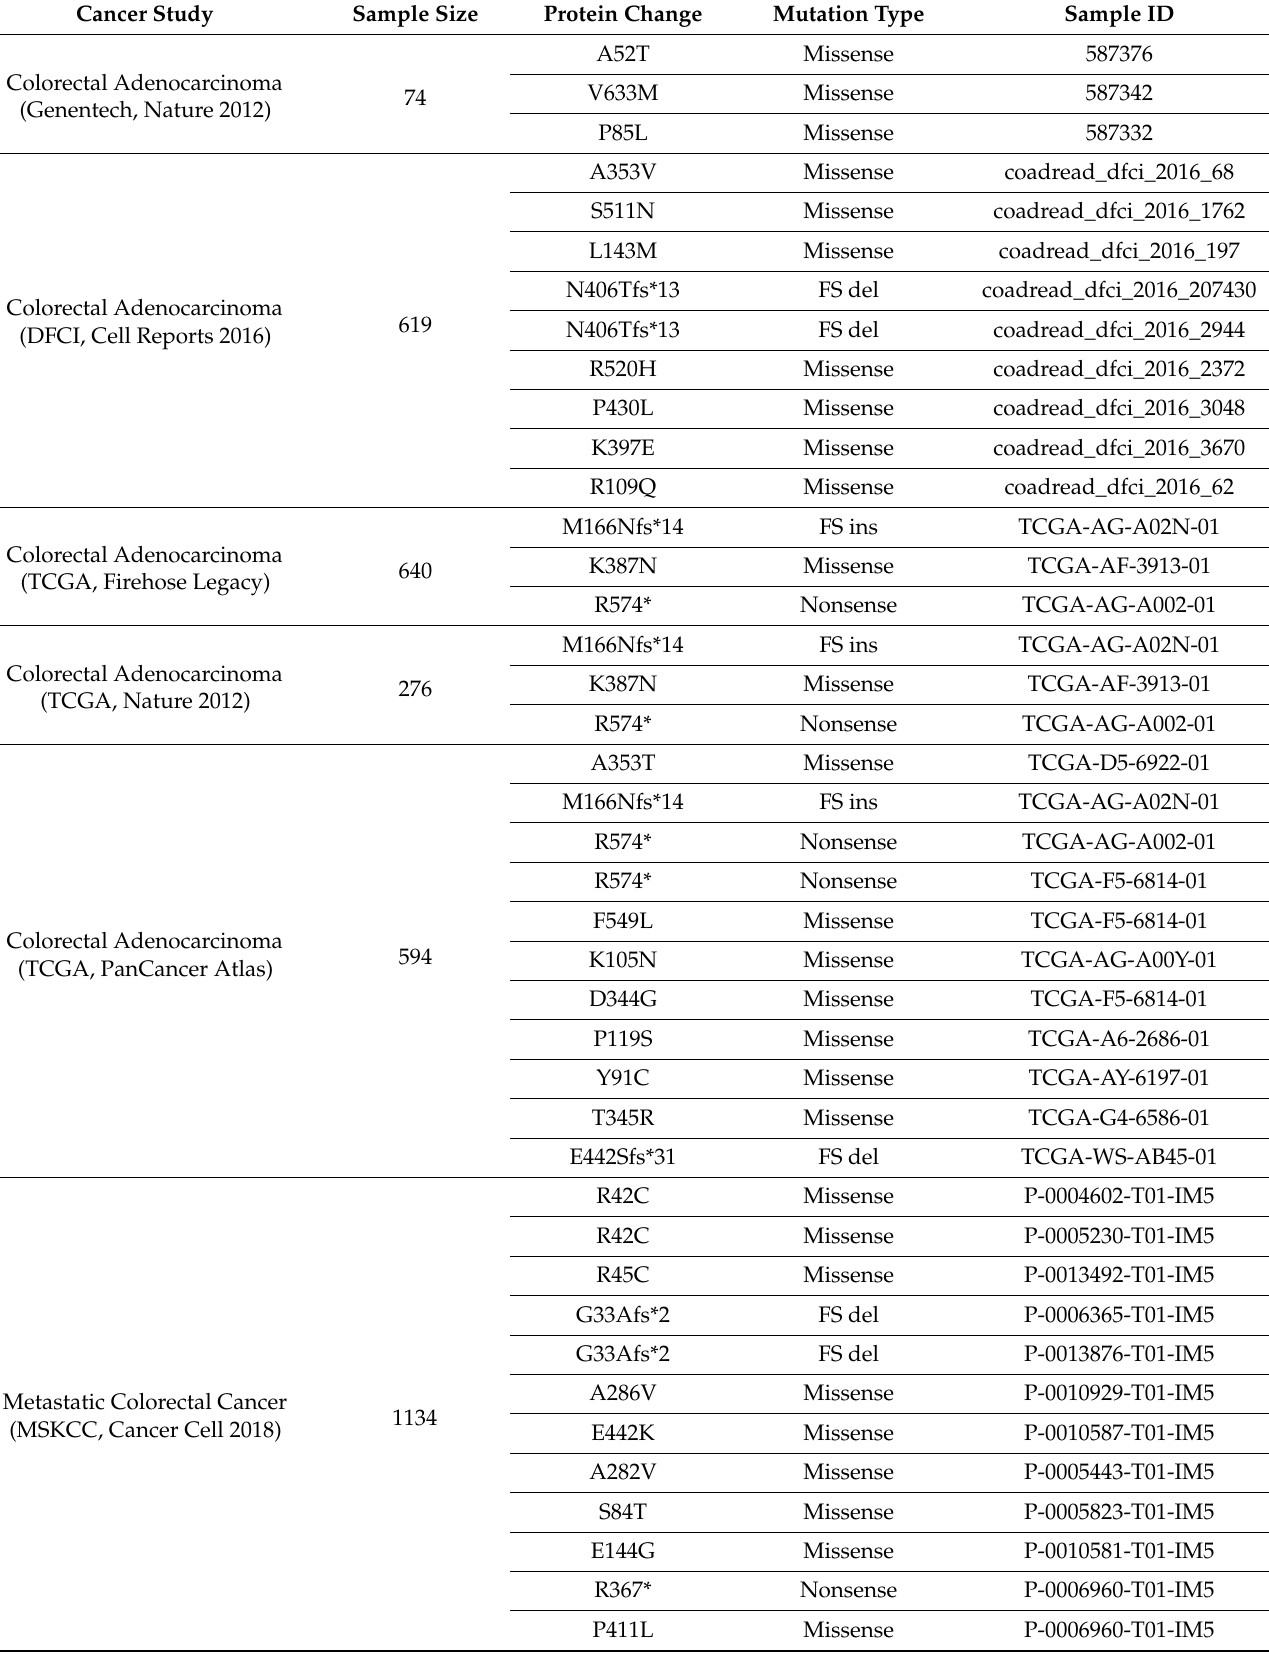
Table 1. A rundown of the hereditary shifts in SYK protein arrangements related to CRC advancement. In total, 57 mutations are detected, including seven duplicate mutations in patients with multiple